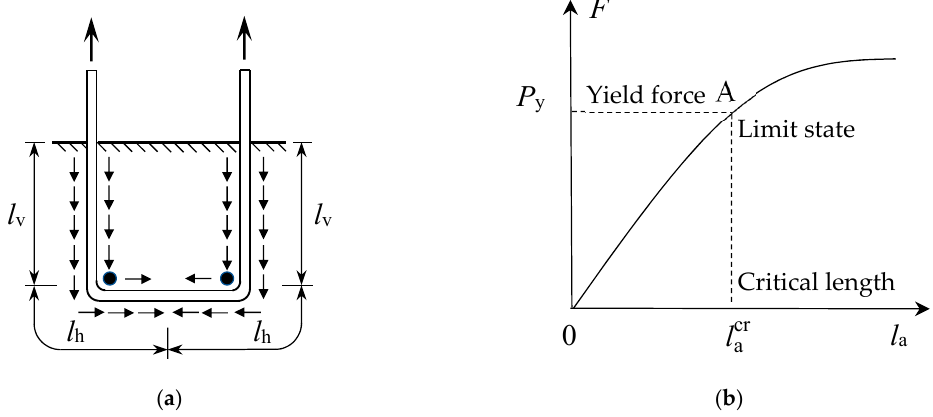
Figure 15. Anchorage limit state. ( a ) Mechanical diagram of the ring rebar; ( b ) Anchoring curve.